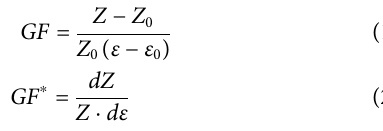
Frontiers in Materials |